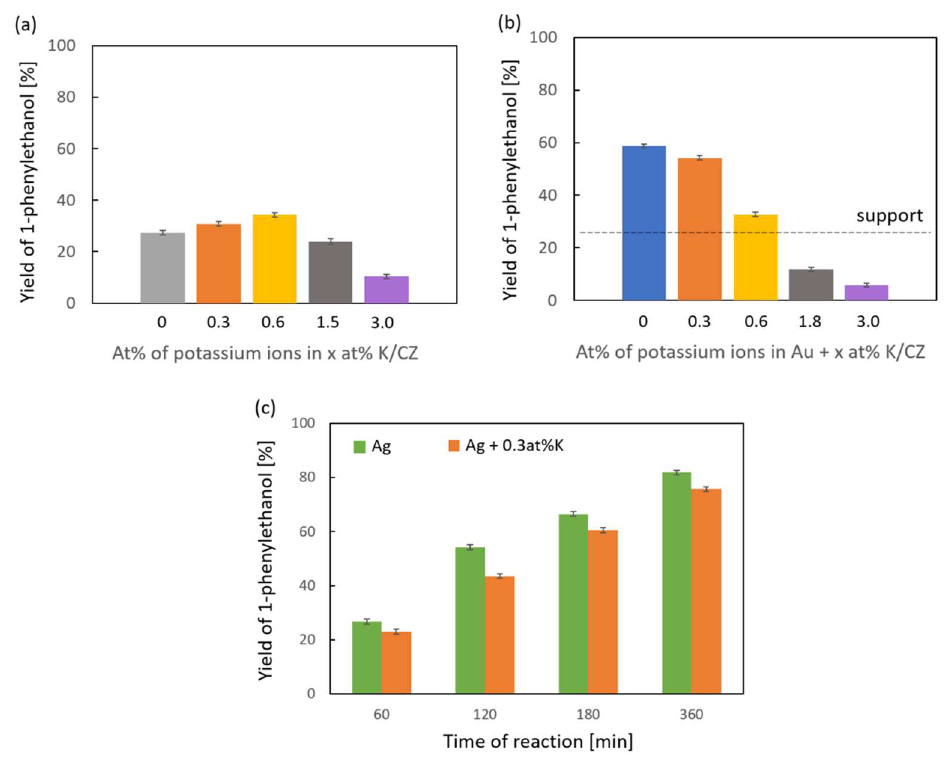
Figure 5. Impact of the presence of potassium ions on the yield of 1-phenylethanol after 5 h of reaction over ( a ) Ce 0.85 Zr 0.15 O 2 , ( b ) Au/Ce 0.85 Zr 0.15 O 2 and ( c ) Ag/Ce 0.85 Zr 0.15 O 2 .